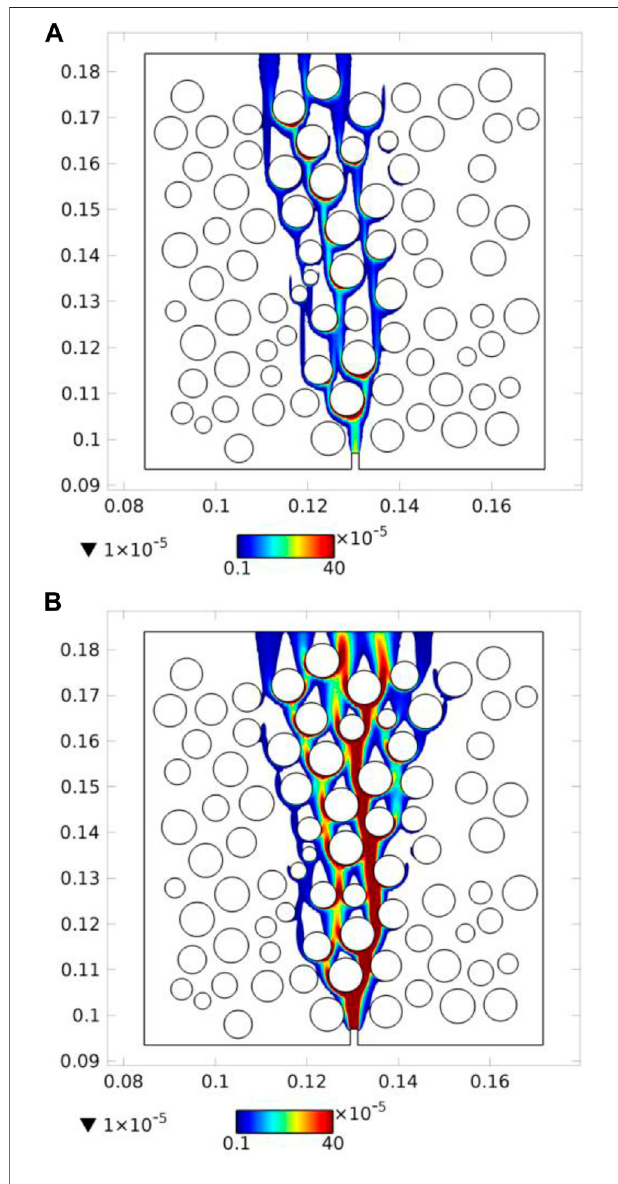
FIGURE 11 | The gas volume fraction distributions under two drag coef fi cients: the C d in Figure 11 (B) is 100 times larger than the C d in Figure 11 (A) . The round circles are the particles in the